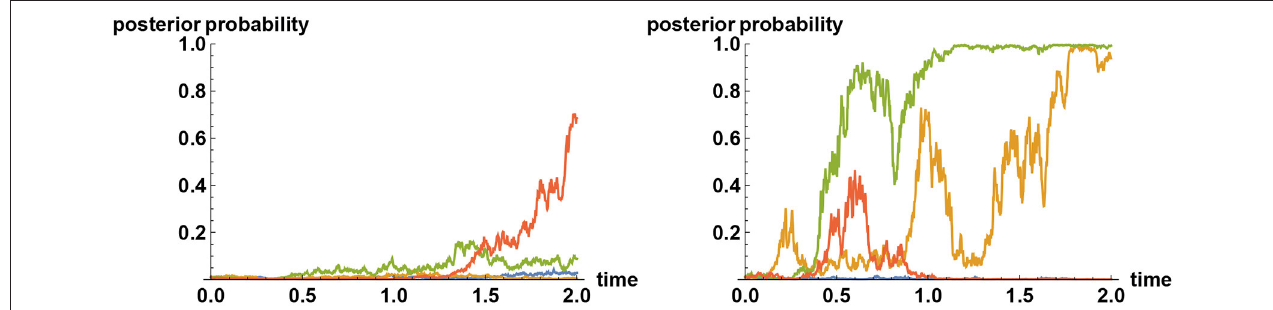
FIGURE 6 | Tenacious Bayesian binary decision with enhanced noise. What happens to the tenacious Bayesian behavior of the left panel in Figure 3 if the noise level is enhanced in such a way that decision makers are unaware of it? As in the example of Figure 3 , the decision makers here have their priors set at 99% for the choice X 0, but the simulator has chosen X 1 to be the correct choice. Plotted here are sample paths for the a posteriori probability that X = = level is doubled as compared to that of the left panel in Figure 3 ; whereas in the right panel it is quadrupled. In both cases, the information flow rates are the same as that chosen in Figure 3 , so no more reliable information is provided here for the Bayesian decision makers. Nevertheless, the introduction of unknown noise enhances the chance of arriving at the correct decision considerably sooner, with positive probability. In particular, if the noise level is quadrupled, then there is about 15% chance that the noise will assist such an escape from a false reality after two